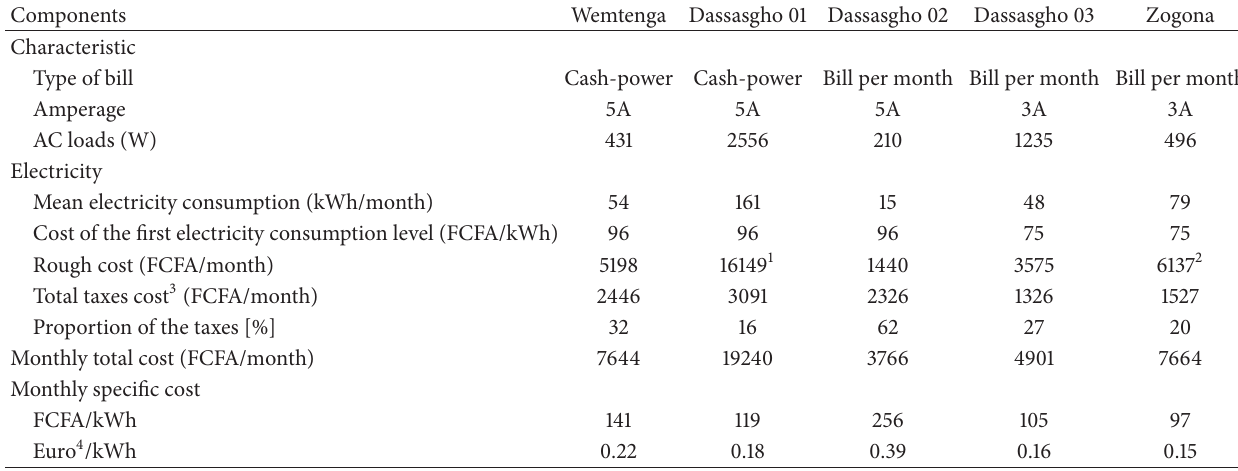
Table 2: Estimate of the average cost of the electricity consumed from